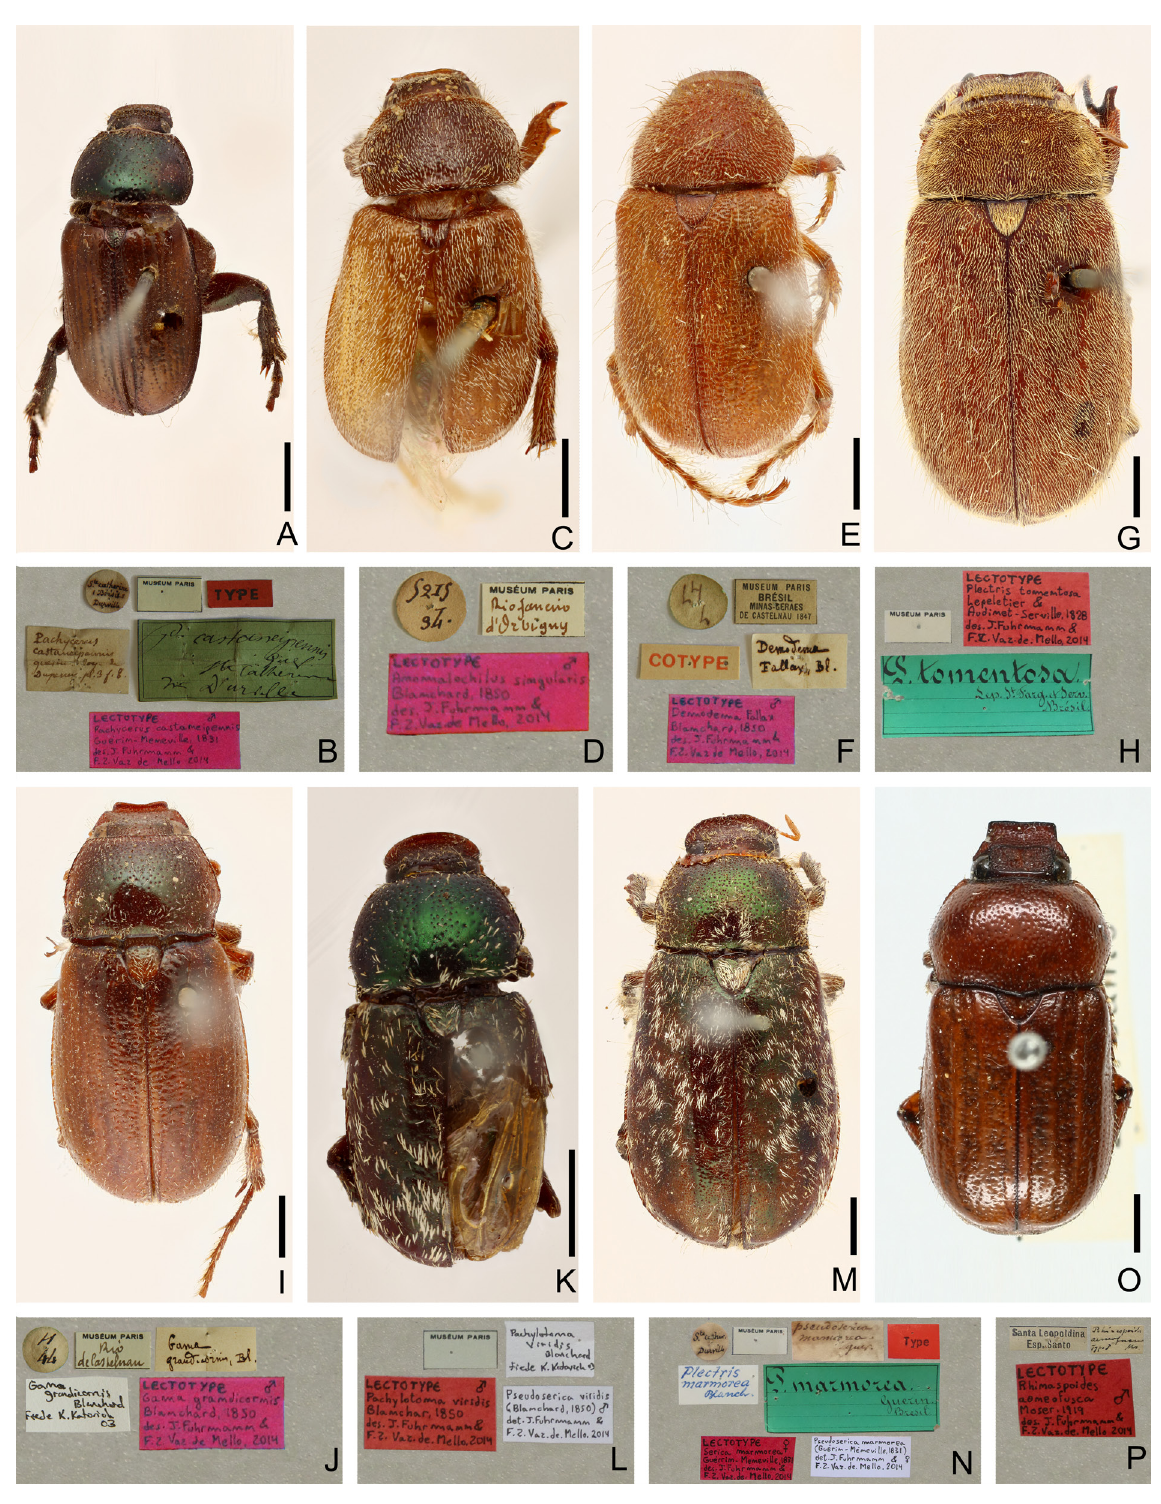
Fig 20. Lectotypes (dorsal, labels). A–B . Pachycerus castaneipennis Guérin-Méneville,